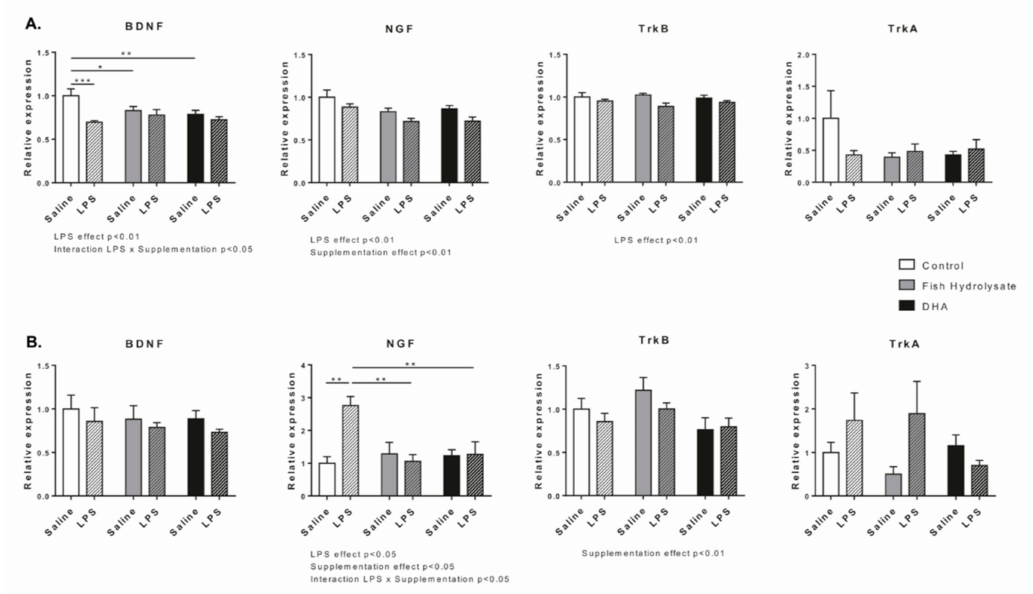
Figure 5. Gene ( A ) and protein ( B ) expression of neurotrophins (BDNF, NGF) and their receptors (TrkB and TrkA) in the hippocampus of mice fed orally with control solution (in white), fish hydrolysate (in grey) or DHA (in black) by daily gavage for 18 days, 2 h following LPS injection (125 µ g/kg) (hatched bars) (* p < 0.05, ** p < 0.01, *** p < 0.001 by 2-way ANOVA and Fisher’s LSD post-hoc test; n = 4–6 per group). Data are presented as mean ± SEM. DHA: docosahexaenoic acid; LPS: